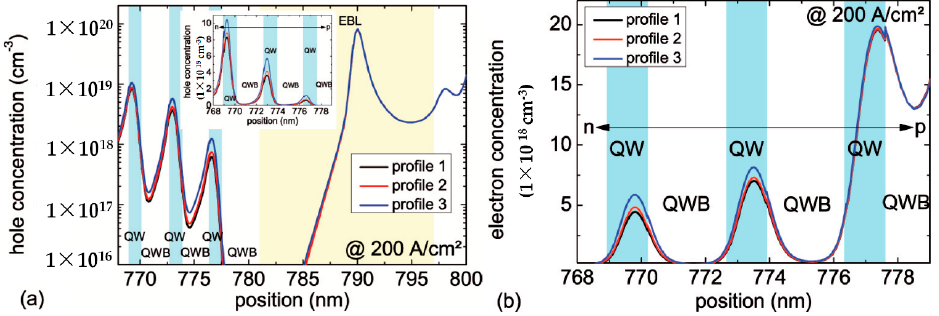
Figure 3. Simulated ( a ) hole concentration and ( b ) electron concentration of 310 nm LEDs with different doping profiles in the EBL (at 200 A/cm 2